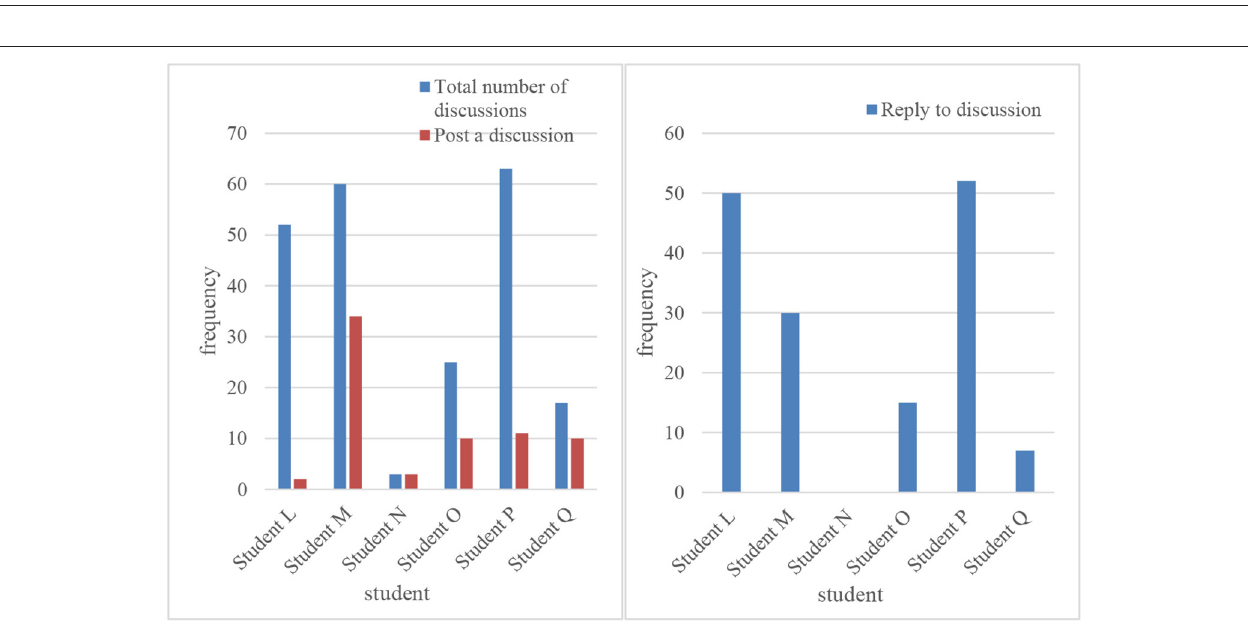
FIGURE 7 | Discussion of students’ online courses.